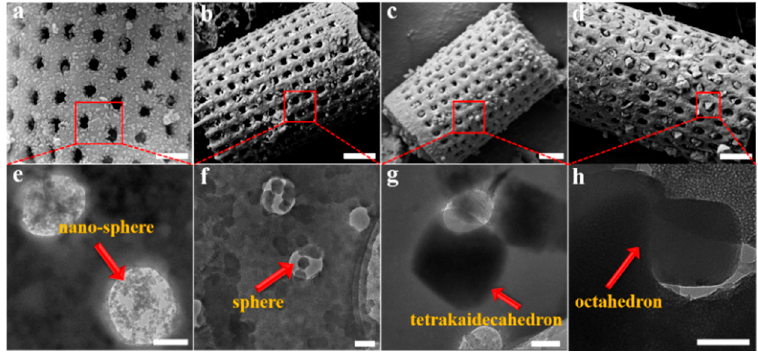
Figure3. ( a – d )SEMimagesofCr-MIL-101@Da, scalebar = 1 µ m, and( e – h )TEMimagesoftheembedded Figure 3. ( a – d ) SEM images of Cr-MIL-101@Da, scale bar = 1 μ m, and ( e – h ) TEM images of the Cr-MIL-101 particles in Da, scale bar = 200 embedded Cr-MIL-101 particles in Da, scale bar = 200 nm.